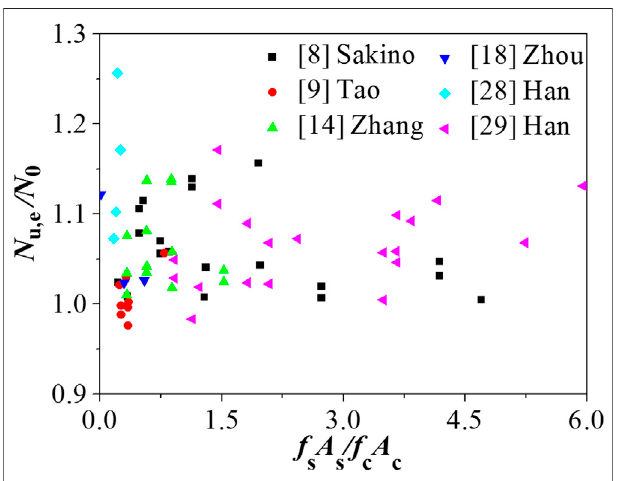
FIGURE 12 | Comparison between formula calculation results and FE calculation results.